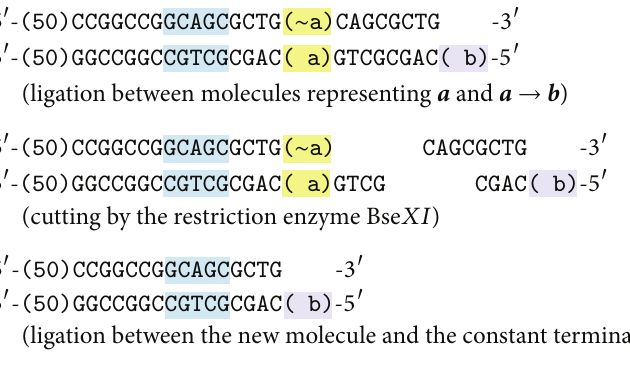
Figure 5: The reaction of inference for a and a → b